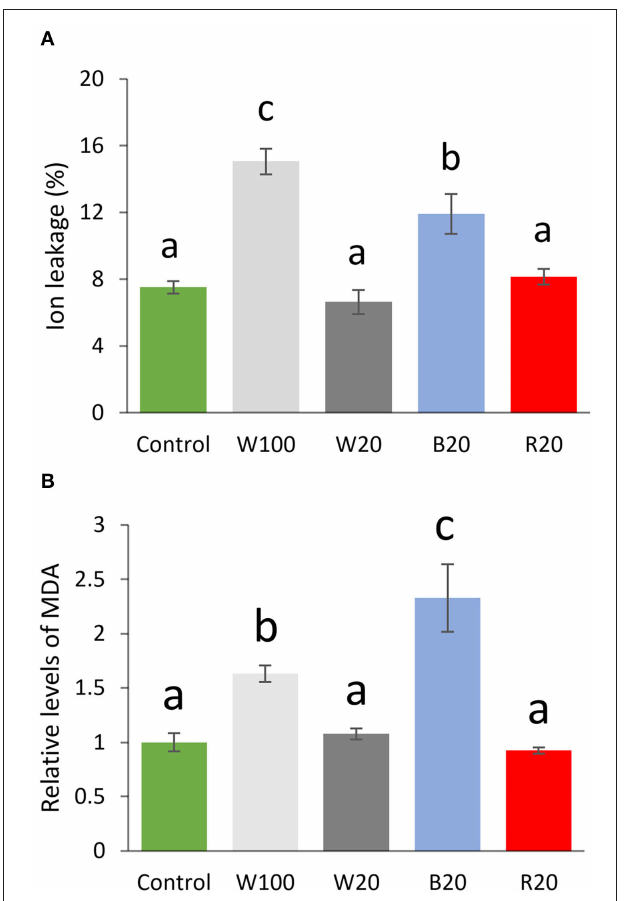
FIGURE 2 | Membrane damage and lipid peroxidation of plants treated by low temperature under different light regimes. (A) Ion leakage and (B) relative level of malondialdehyde (MDA) normalized to control and compared to control. Results represent means of three biological replicates with standard errors, letters indicate significant differences (ANOVA, Tukey’s HSD post hoc test, p < 0.05). W100, cold treatment under 100 µ mol m − 2 s − 1 white light; W20, cold treatment under 20 µ mol m − 2 s − 1 white light; B20, cold treatment under 20 µ mol m − 2 s − 1 blue light; R20, cold treatment under 20 µ mol m − 2 s − 1 red